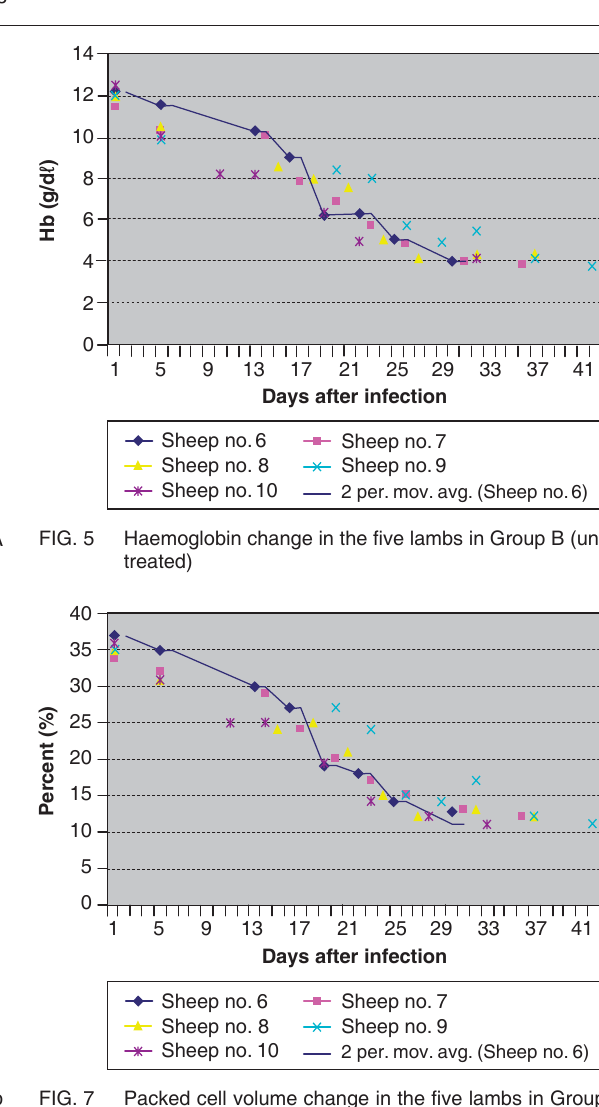
FIG. 7 Packed cell volume change in the five lambs in Group B